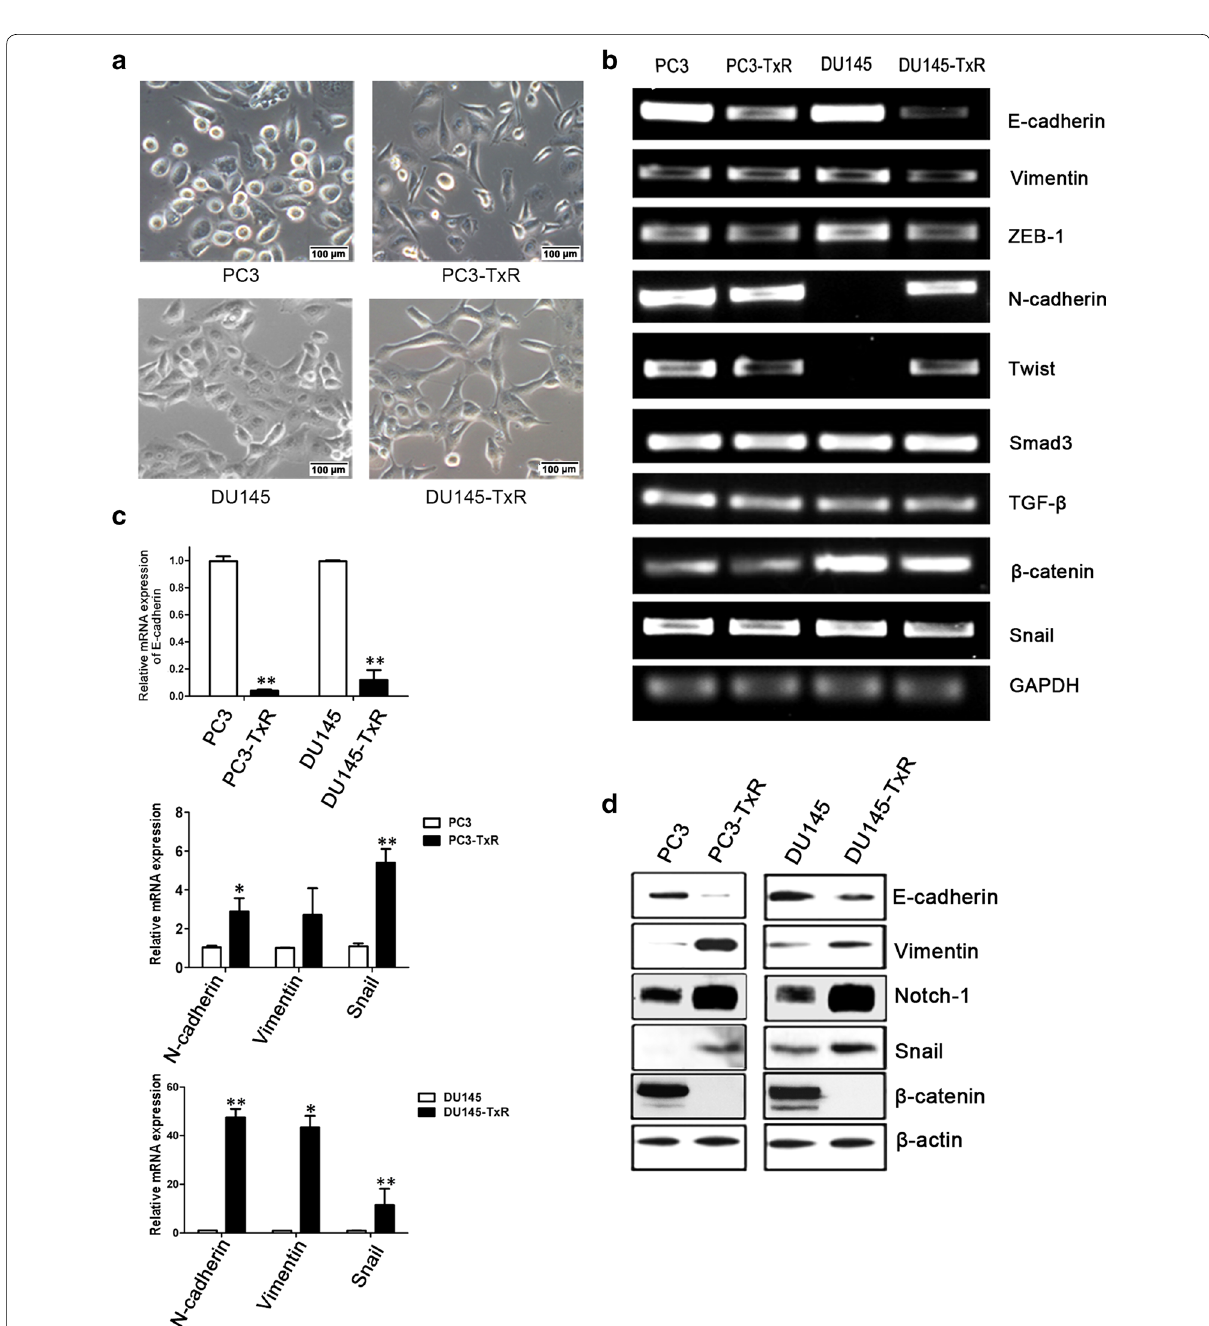
Fig. 1 Chemoresistant prostate cancer (PCa) cells show epithelial-to-mesenchymal transition (EMT) changes comparing with their parental cells. a Morphology of parental PC3 and DU145 cells, and chemoresistant PC3-TxR and DU145-TxR cells was observed under a microscope at 200 magnification. b The expression of EMT markers in PC3, DU145, PC3-TxR, and DU145-TxR cells was detected using semi-quantitative reverse × transcription-polymerase chain reaction (RT-PCR). ZEB - 1 , E-box binding homeobox-1; TGF - β , transforming growth factor beta; GAPDH , glyceral- dehyde-3-phosphate dehydrogenase. c Quantitative real-time PCR (qPCR) analysis results show alterations in the mRNA levels of EMT markers in chemoresistant cells comparing with parental cells. d The expression of EMT-related proteins in PC3, DU145, PC3-TxR, and DU145-TxR cells was analyzed using Western blotting assay. Quantification data are presented as mean standard error of the mean (SEM). ** P < 0.01, * P < ±